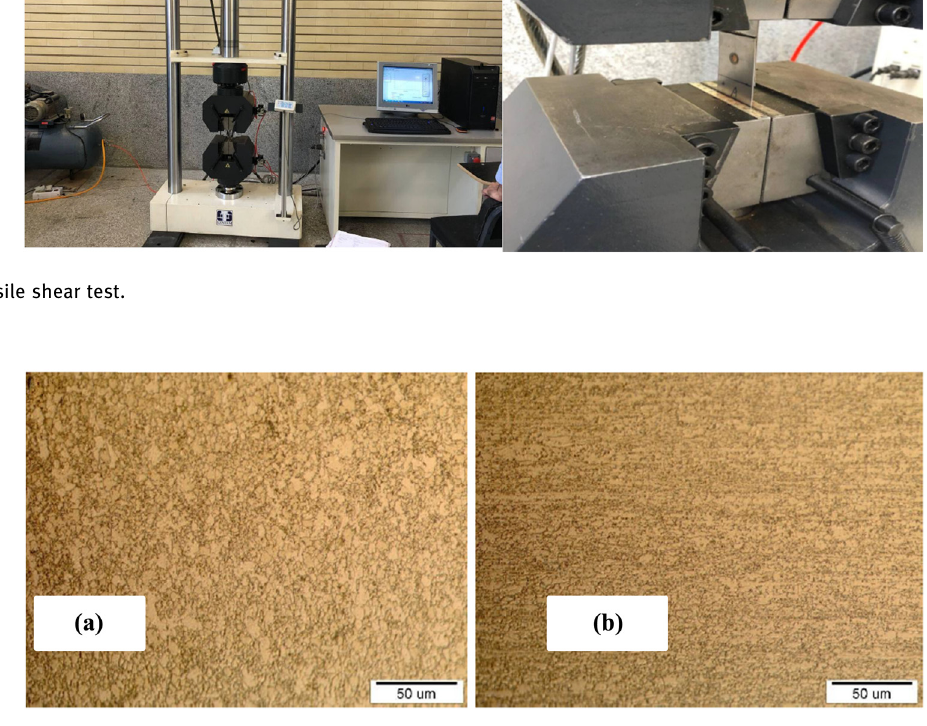
Figure 11: ( a ) Top surface. ( b ) Cross section.